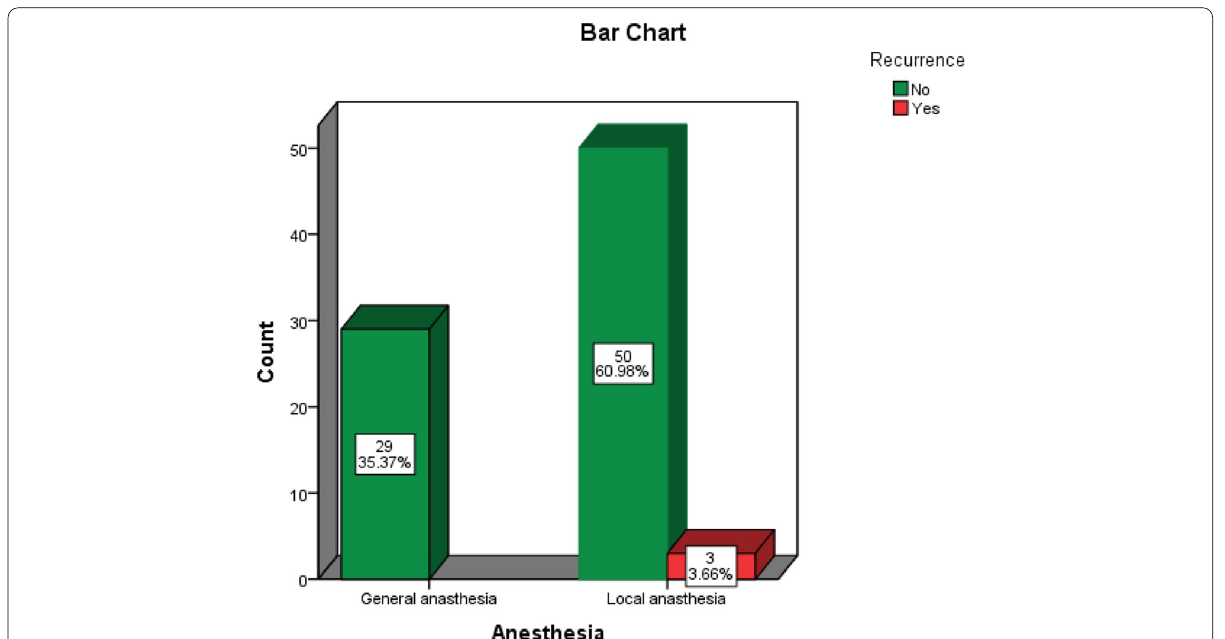
Fig. 1 The association between anesthetic type and recurrence in 82 patients with intranasal LCH. P ‑value